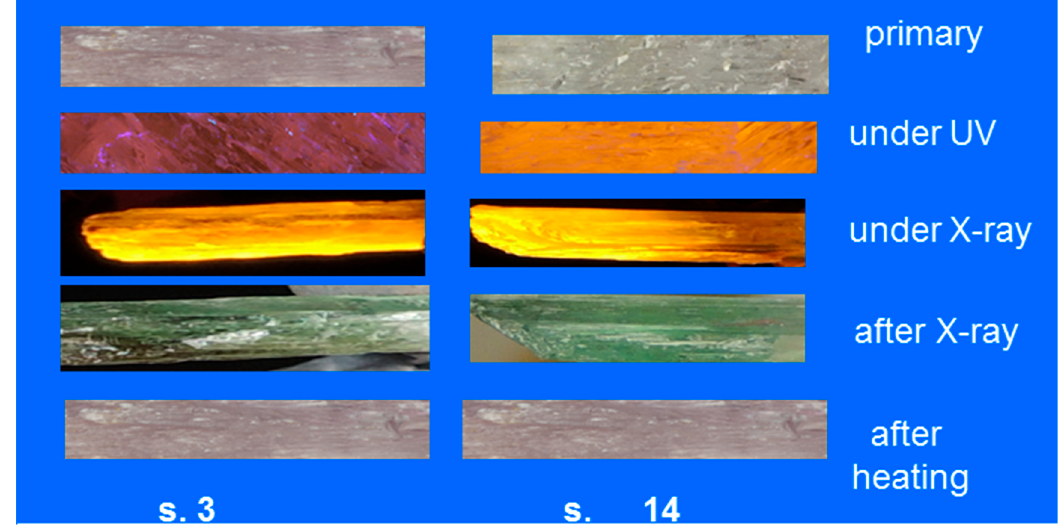
Figure 3. Studied samples before and after irradiation and heating.